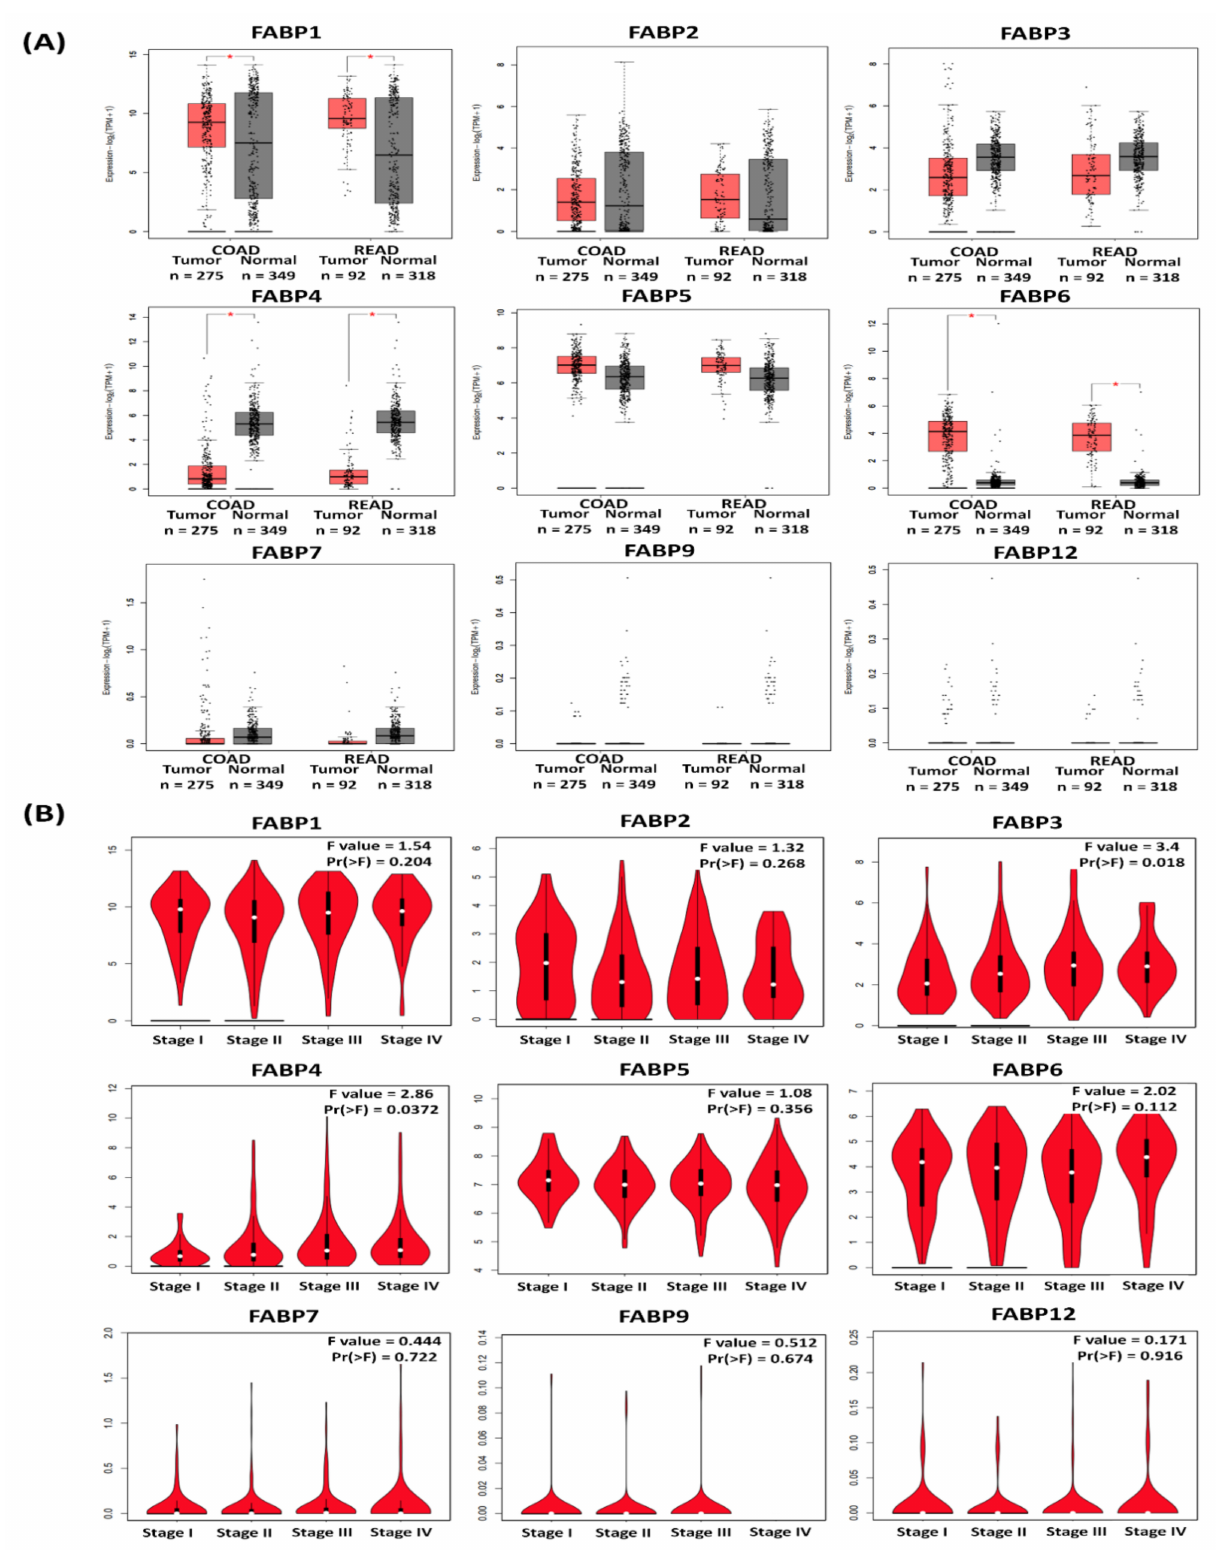
Figure 4. Gene expression profile of the fatty acid-binding proteins ( FABP s) in CRC. ( A ) Gene expression analysis of FABP s genes using GEPIA based on TCGA database. Boxplot of transcriptional levels of FABP s in terms of log 2 (TPM + 1) in COAD ( n = 275) vs. normal samples ( n = 349) and READ ( n = 92) vs. normal samples ( n = 318). Red indicates the FABP genes transcriptional levels in COAD and READ tissues, while black indicates the transcriptional levels in normal